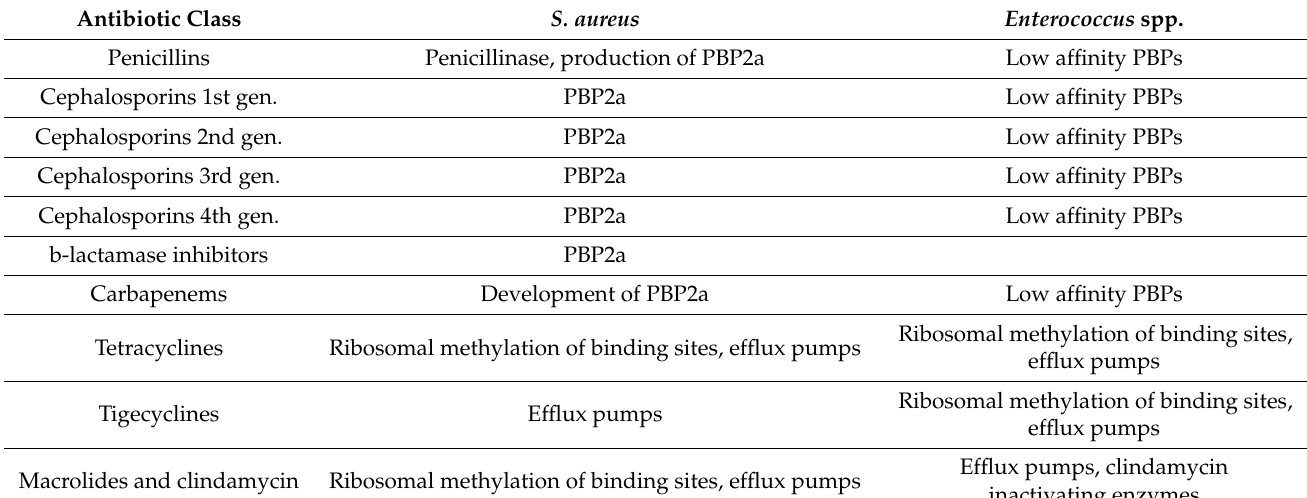
Table 2. Summary of antibiotic resistance mechanisms in important Gram-positive